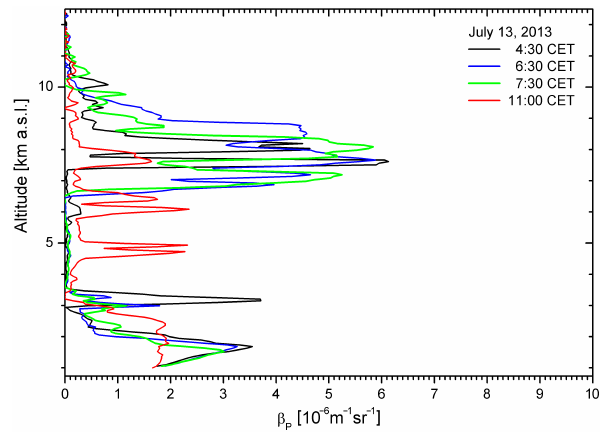
Figure 11. Ozone profiles for 13 July 2013, the upper-tropospheric uncertainty is of the order of 10ppb due to the radiation loss caused by the high densities and the aerosol layers.